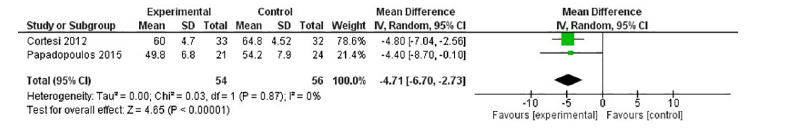
Fig 5. Children’s sleep habits questionnaire total